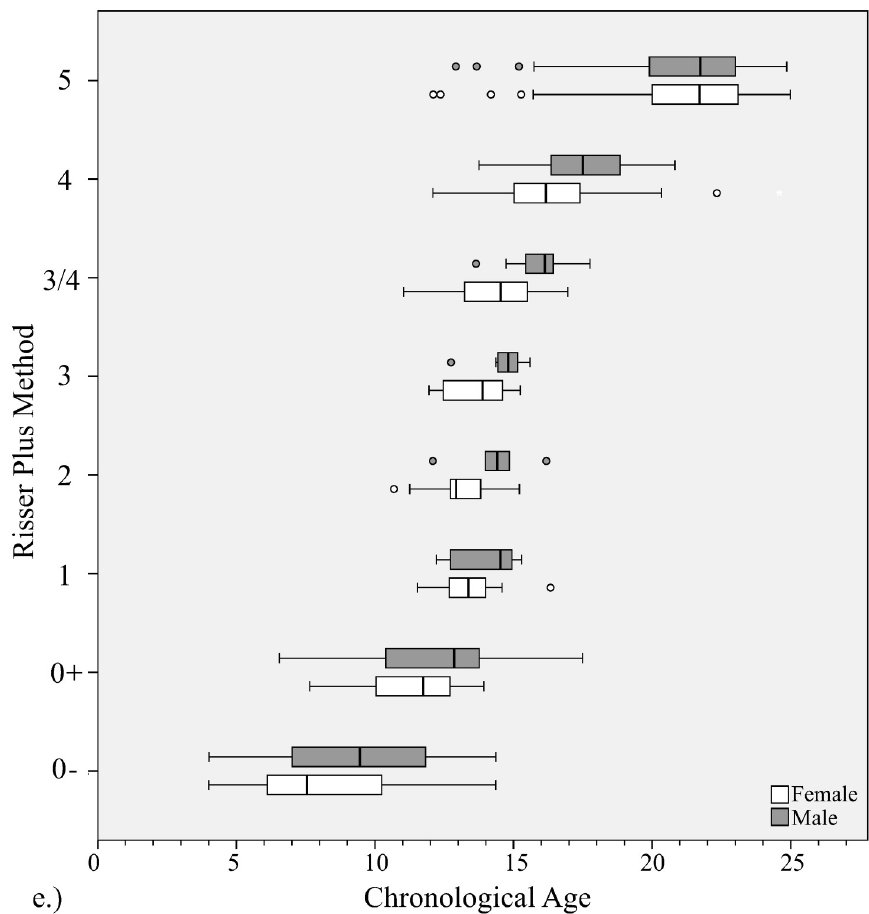
Fig 7. Distribution of chronological ages at each bone age stage with Risser plus method. Gender is shown at each stage.